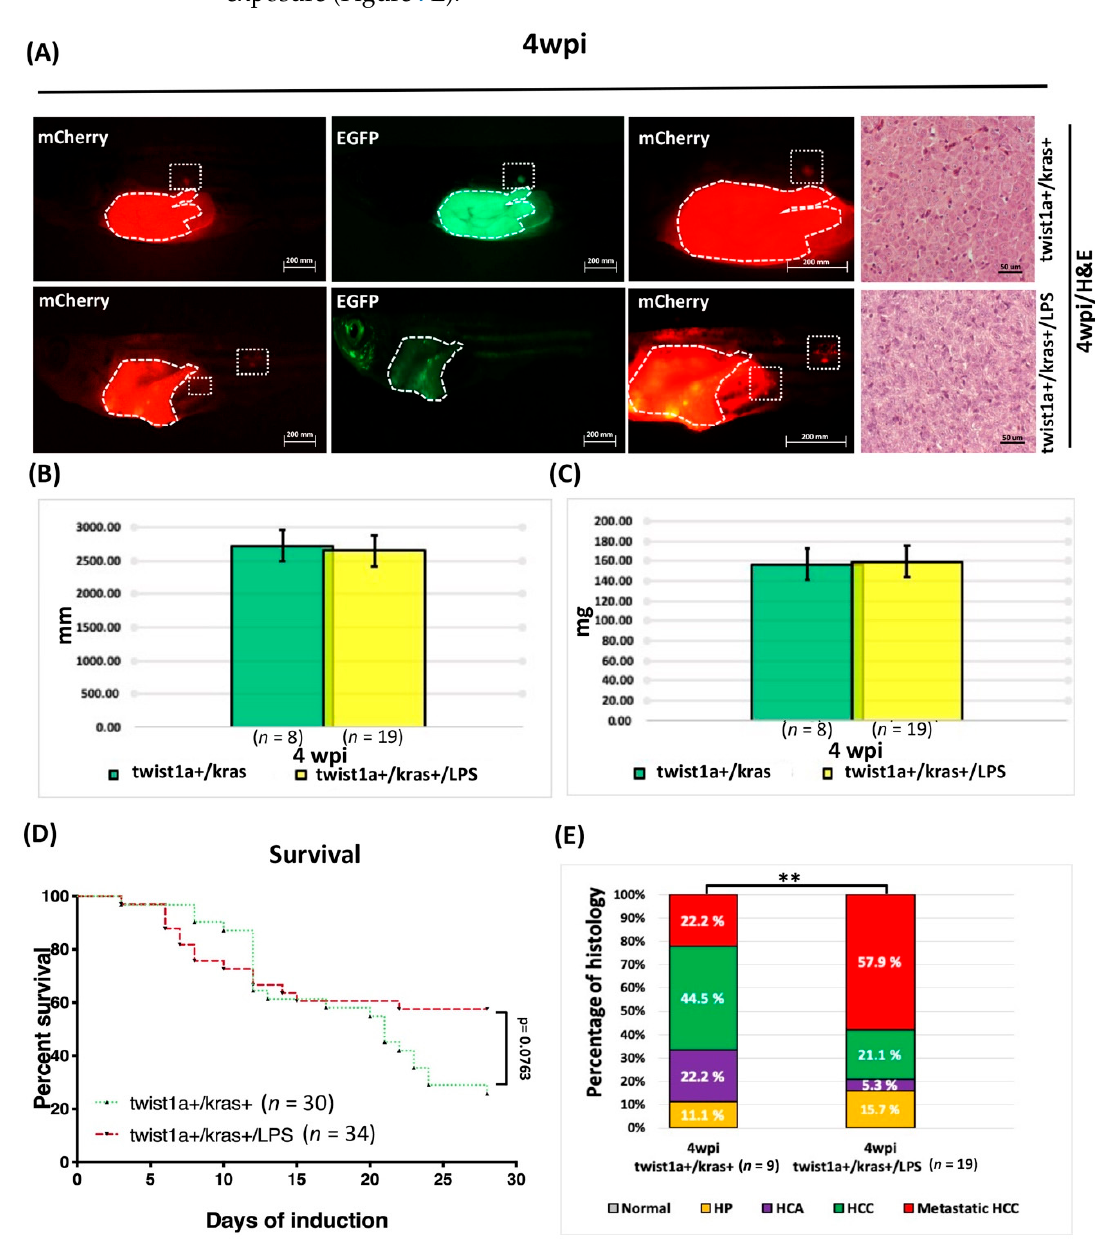
Figure 7. LPS enhanced HCC progression in adult twist1a +/ kras + transgenic zebrafish. Twist1a +/ kras + transgenic zebrafish were treated at 3 mpf with Dox and 4-OHT or with Dox, 4-OHT and LPS exposure. Samples were taken at 4 wpi. ( A ) Immunofluorescence analysis of mCherry and EGFP-labeled metastatic liver tumors and H&E staining of liver tissues from twist1a +/ kras + and twist1a +/ kras +/LPS zebrafish at 4 wpi (white dotted frame: primary and metastatic liver tumors). ( B , C ) No significant differences in body lengths or weights were found between twist1a+ / kras+ and twist1a+ / kras+ /LPS transgenic zebrafish at 2 and 4 wpi. ( D ) Kaplan-Meier survival curves show the percentage of sur- vival up to 4 wpi. ( E ) Histological analysis revealed that twist1a +/ kras + and twist1a +/ kras +/LPS trans- genic zebrafish developed HCC or metastatic HCC at 4 wpi. Scale bar: 50 or 200 μ m. Student’s t -test or one-way ANOVA were used to assess differences between variables: ** p < 0.01.